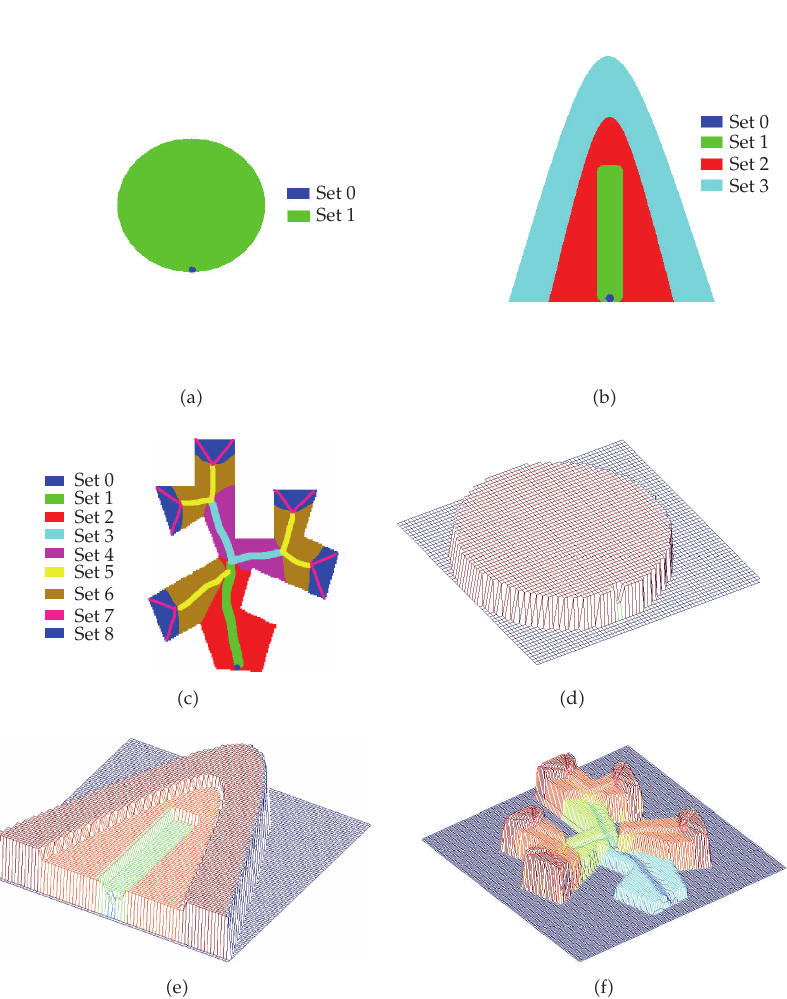
Figure 1: Tidal basins with di ff erent assumptions: (cid:2) a (cid:3) flat tidal basin, (cid:2) b (cid:3) tidal basin with a channelized and nonchannelized zones (cid:2) multiple sets of topological significance (cid:3) , and (cid:2) c (cid:3) tidal basin with multiple sets, sets indexed with even and odd indexes, respectively, refer to channelized and nonchannelized zones. (cid:2) d (cid:3) – (cid:2) f (cid:3) 3D mesh representations of three synthetic tidal basins shown in (cid:2) a (cid:3) – (cid:2) c (cid:3) .